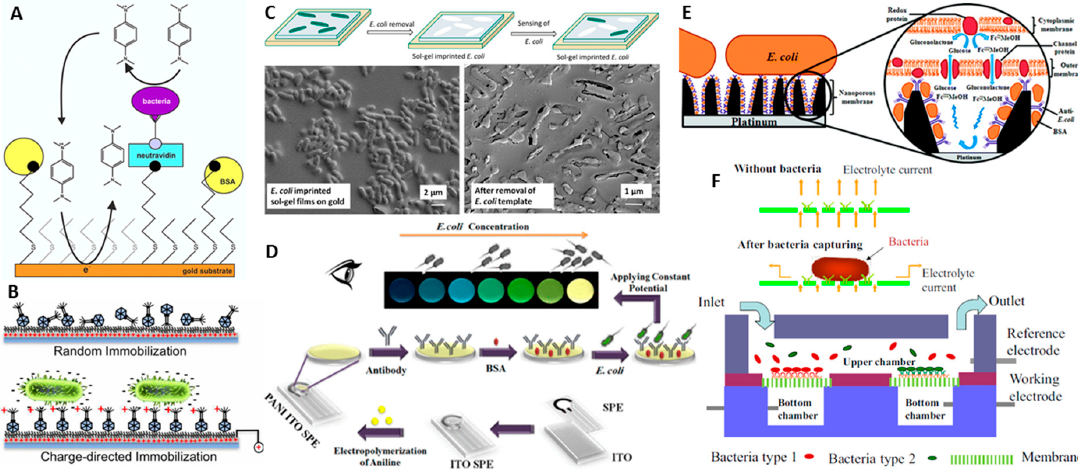
Figure 3. Selected examples of bacterial sensors based on ( A ) immune-recognition and electrochemical assessment of viable cell metabolism [143]; ( B ) Phage-based bacterial cell assay [144]; ( C ) Whole cell imprinted polymer sensor based on E. coli imprinting into ultrathin silica films on gold-coated glass slides [145], ( D ) Electro-chromic immunoassay [146]; and ( E ) Electrochemical nanopore immunoassay [147], and ( F ) Nanopore e-immunoassay integrated within the microfludic device [99]. Copyright (2019), (2017), (2019), and (2011) American Chemical Society and copyright (2016) and (2019) Elsevier.